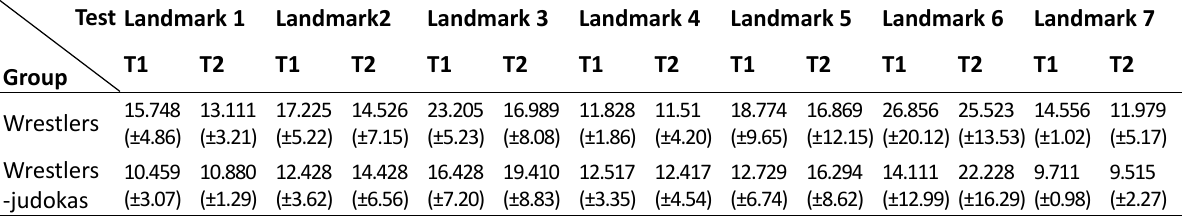
Table 2. Peaks of acceleration (m/s²) on the level of the various landmarks for the wrestlers and the wre-judokas during the first and the second test. Average values and standard